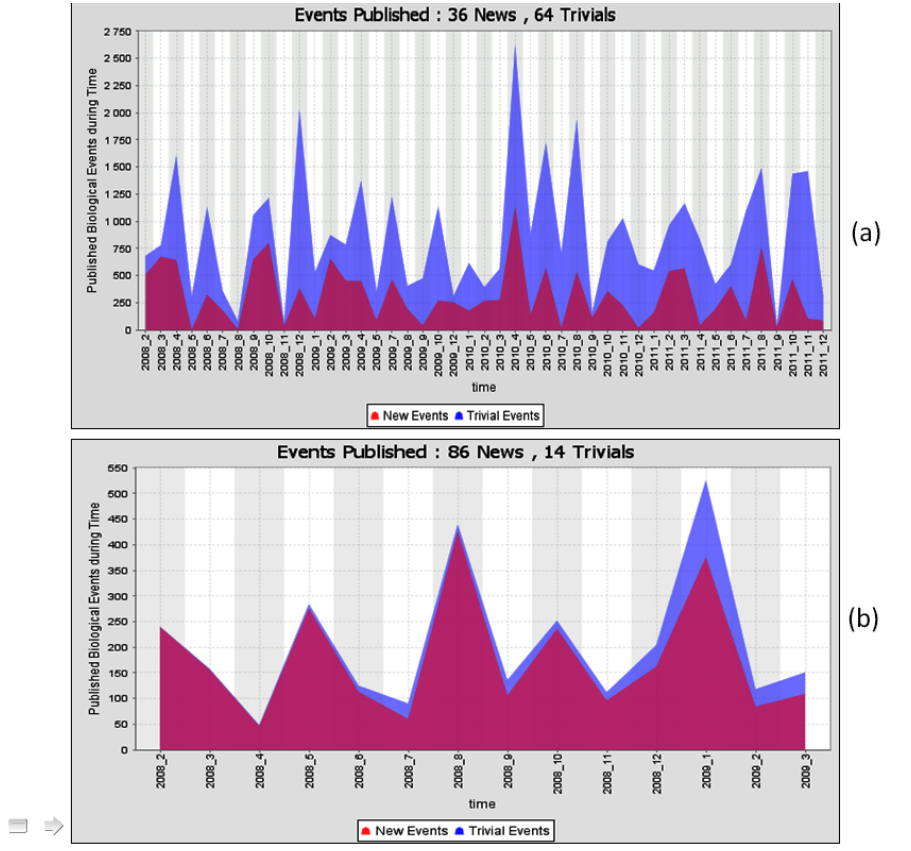
Figure 13. Comparative study of extracted events for queries “BMP6” (as a gene) and “Osteoporosis” (as a